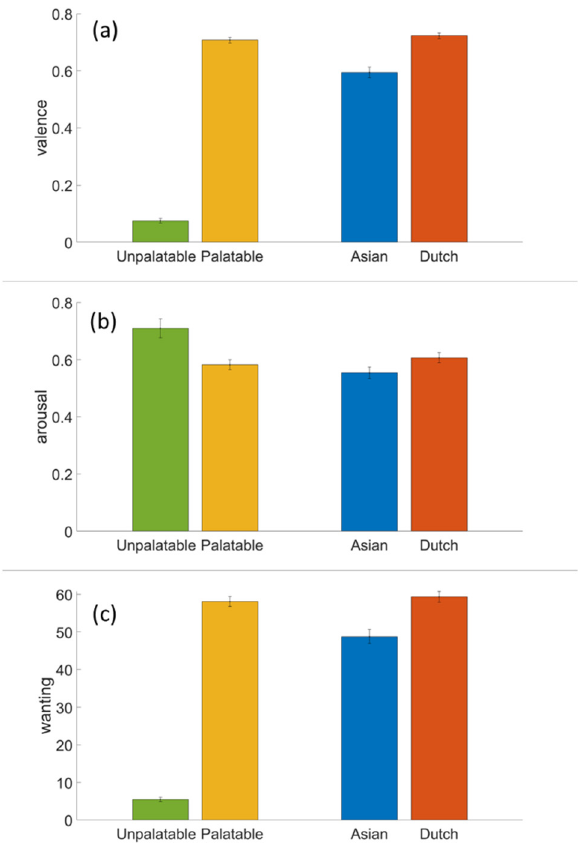
Figure 3. Explicit ratings valence ( a ), arousal ( b ) and wanting ( c ) for each of the four stimulus categories. Error bars indicate standard errors of the mean.